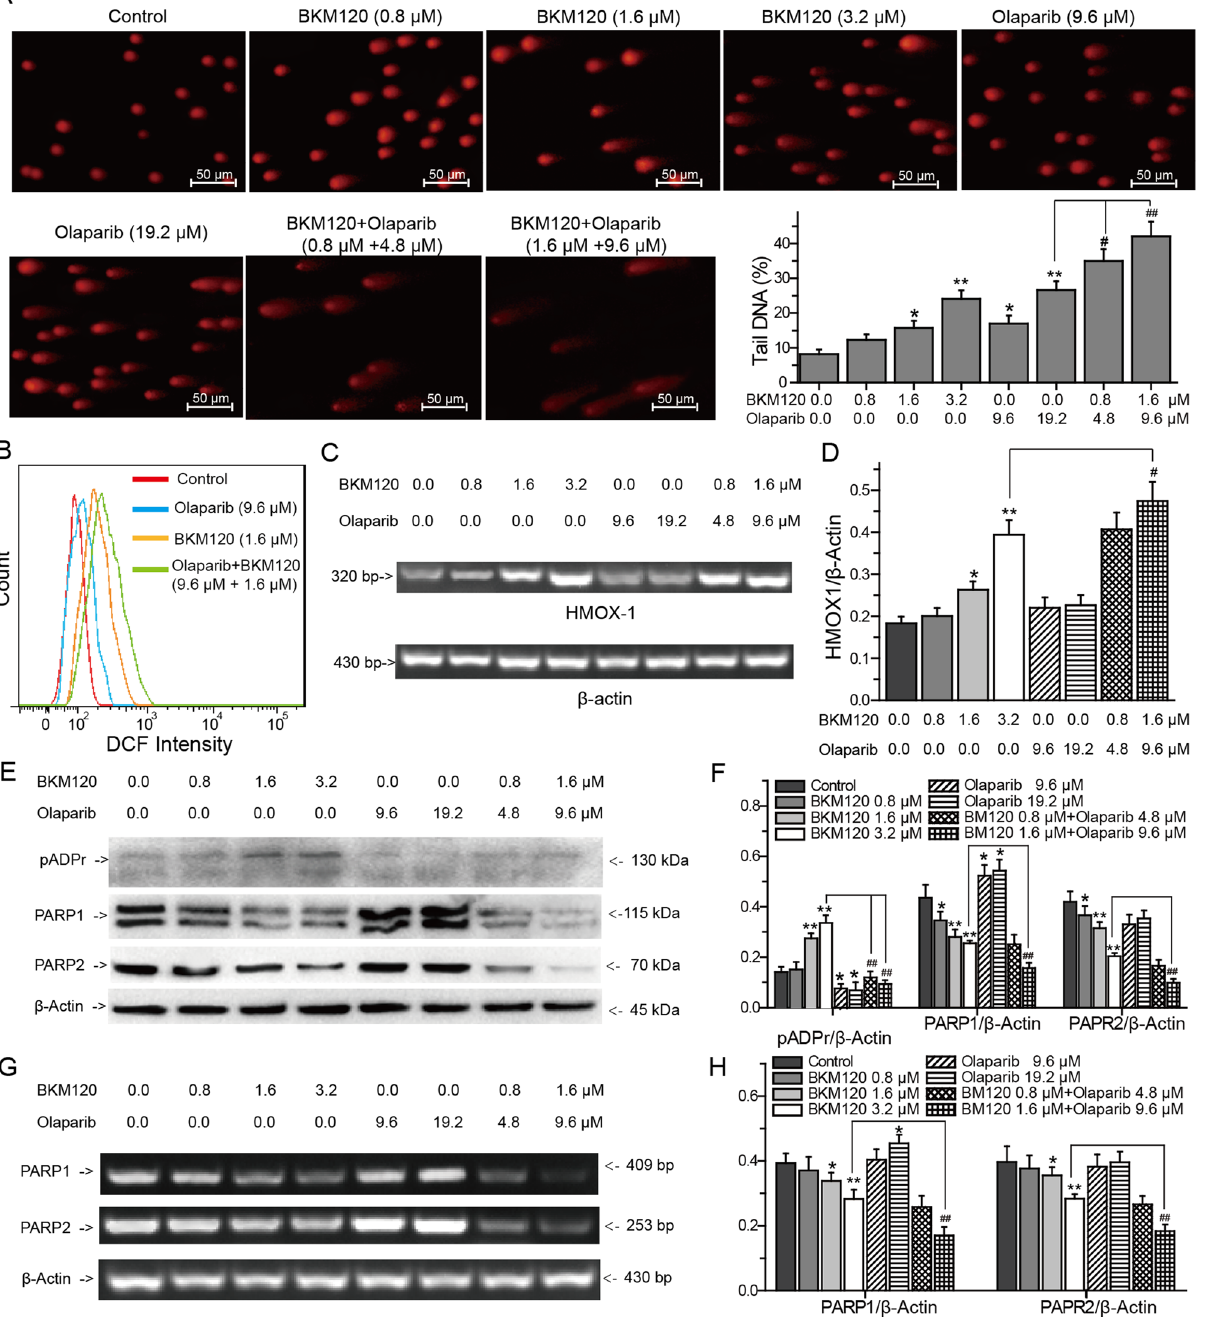
Figure 2. Effects of BKM120 and olaparib on DNA damage in MDA-MB-231 cells. ( A ) DNA damage was assessed by alkaline comet assay. The tail DNA percentage of comet assay at indicated concentration of BKM120, olaparib, and their combination. ( B ) Effects of drugs on cellular ROS analyzed by flow cytometry. ( C ) RT-PCR analysis of the expression of HMOX-1 induced by drugs. ( D ) Percentage of relative intensity obtained from the corresponding RT-PCR. ( E ) Effects of drugs on the expressions of pADPr, PARP1 and PARP2 analyzed by western blots. ( F ) Relative intensity expression obtained from the corresponding western blots. ( G ) Effects of drugs on the expressions of PARP1 and PARP2 in MDA-MB-231 cells analyzed by RT-PCR. ( H ) Relative intensity expression obtained from the corresponding RT-PCR. Error bars represent SEM from the mean of three separate experiments. * P < 0.05 and ** P < 0.01 compared to control, # P < 0.05 and ## P < 0.01 compared to 3.2 μM BMK120-treated